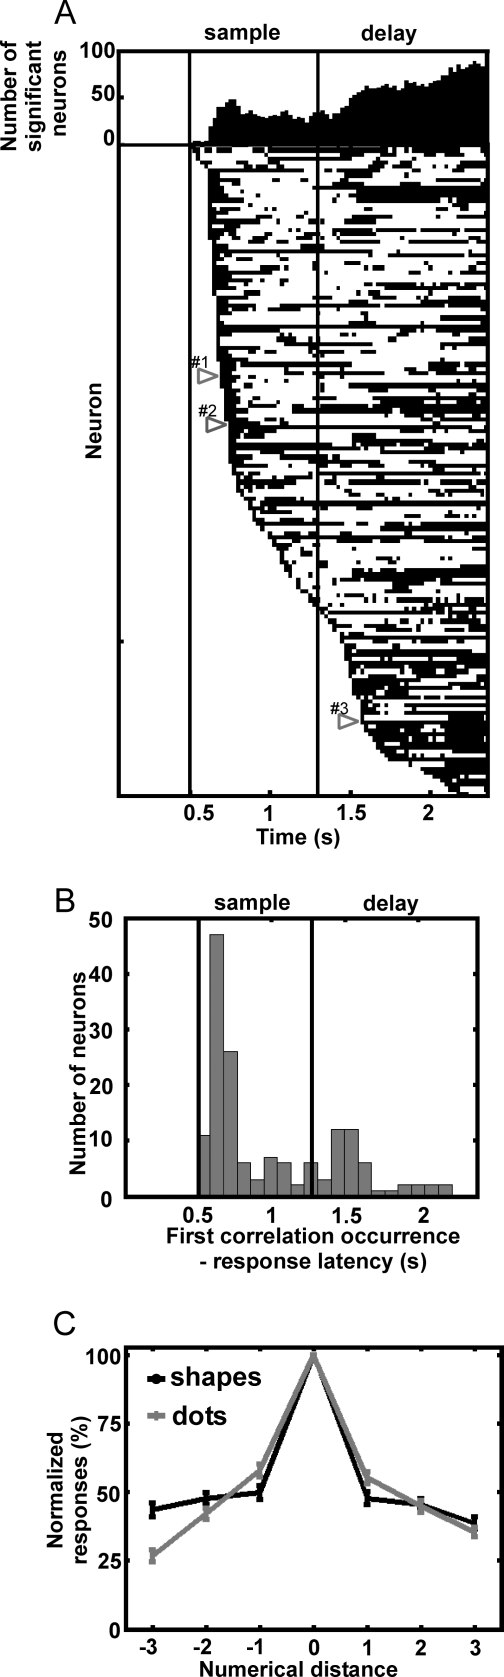
Association Neurons in the PFC(A) Diagram showing the temporal evolution of significant (as determined by a sliding ROC analysis; see Materials and Methods) cross-correlations between the tuning functions of 157 individual neurons to the dot and shape protocols. Top panel: Number of association neurons as a function of time. Bottom panel: Time course of association of each individual neuron. Each horizontal line corresponds to one single neuron. Periods of significant correlation are marked in black. Data are sorted by the first time of significant cross-correlation. Time is aligned to the midpoint of the 100-ms sliding windows. Data from example neurons 1–3 in Figure 3 are indicated by gray triangles.(B) Distribution of response-latency-corrected time points at which neurons started to associate numerical values.(C) Population tuning curves. Normalized discharges and averaged tuning curves of all association neurons to the dot (gray) and shape (black) protocols. Data are plotted as a function of numerical distance from the preferred numerical value.